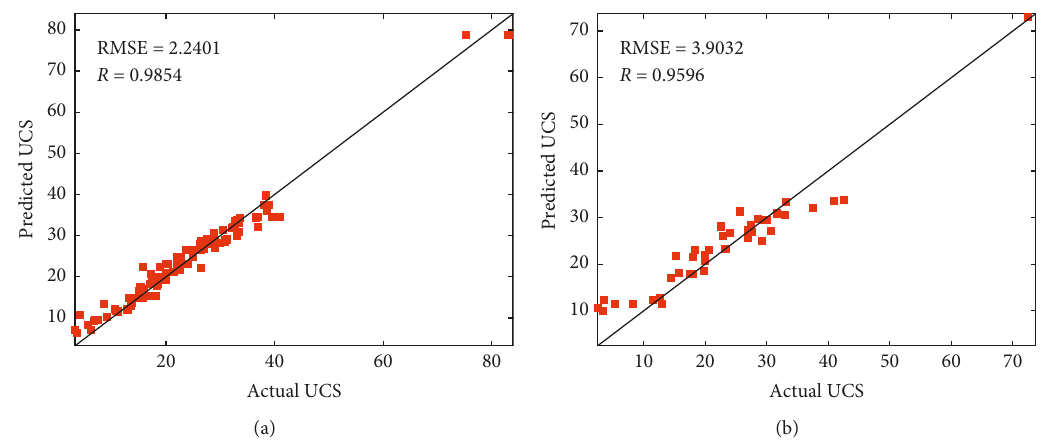
Figure 5: Comparison of UCS values. (a) Training dataset. (b) Testing dataset.